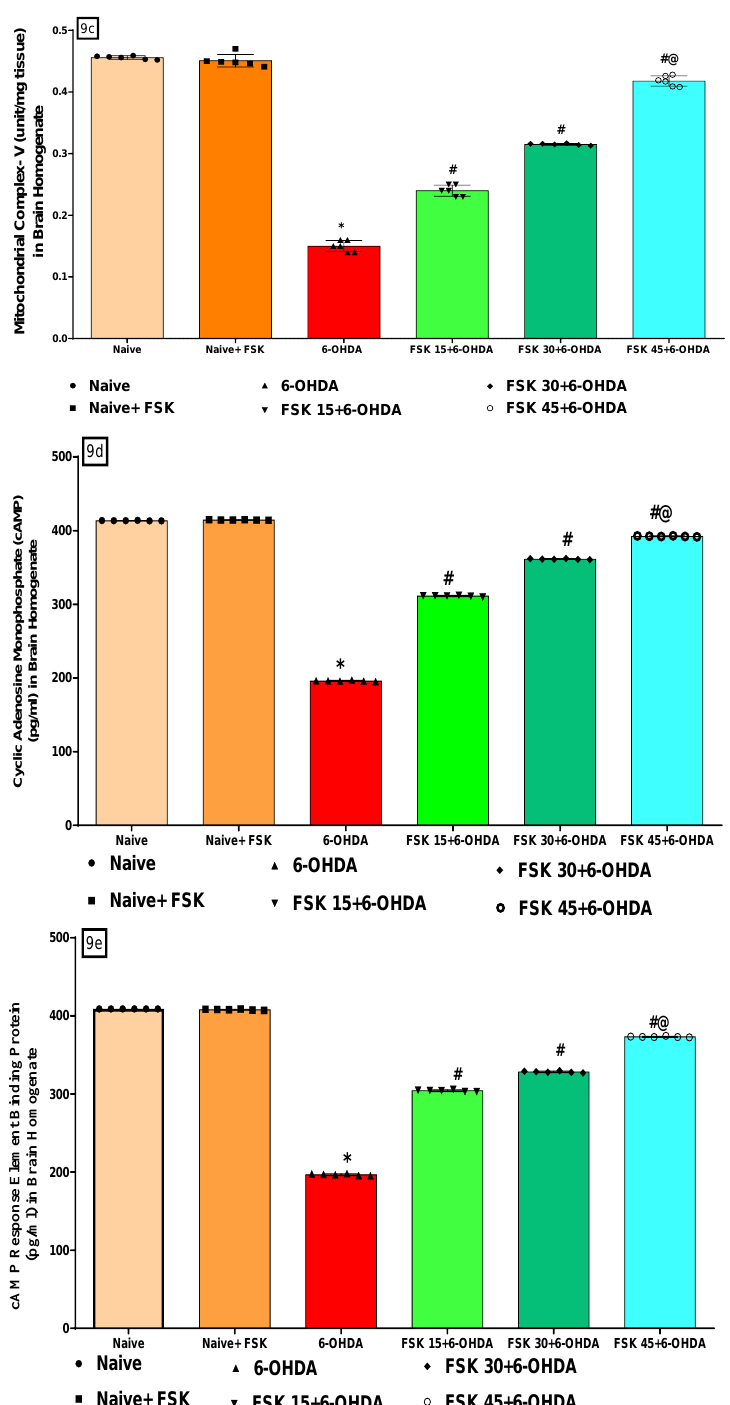
Figure 9. ( a – c ) FSK restored ETC-complexes (I, II, V) enzyme levels in the experimental model of PD. Data provided as mean ± SD (n = 6) followed by ANOVA (one-way) with post-hoc Tukey’s test. * 6-OHDA ( p < 0.01) compared with naive and naive + FSK ; # FSK15, FSK30, FSK45 (p < 0.01) compared with 6-OHDA ; #@ FSK45 (p < 0.01) compared with FSK30, FSK15 . ( d , e ) FSK improved cAMP and CREB protein levels in the experimental model of PD. Data provided as mean ± SD (n = 6) followed by ANOVA (one-way) with post-hoc Tukey’s test. * 6-OHDA ( p < 0.01) compared with naive and naive + FSK # FSK15, FSK30, FSK45 (p < 0.01) compared with 6-OHDA ; #@ FSK45 (p < 0.01) compared with FSK30, FSK15 . FSK Improved cAMP and CREB Protein Levels in the Experimental Model of PD At the end of the protocol schedule, molecular markers (cAMP and CREB) were measured in the rats’ brain homogenate. The naive and naive + FSK (45 mg/kg p.o.) groups showed no statistically significant differences. In contrast to the naive and naive + FSK groups, the amount of cAMP and CREB proteins gradually decreased following the continuous injection of 6-OHDA (8 μg/2 μL/unilateral). Furthermore, the chronic ad- ministration of FSK at doses of 15, 30 and 45 mg/kg compared to the 6-OHDA-treated group showed a significant increase in cAMP [F 5,25 = 1.660; ANOVA (one-way); p < 0.01 (Figure 9d) and CREB [F 5,25 = 1.546; ANOVA (one-way); p < 0.01] (Figure 9e) levels in a dose-dependent manner. In rats with 6-OHDA-induced PD, a high dose of FSK (45 mg/kg) demonstrates a significant improvement in restoring the levels of cAMP and CREB. 2.2.3. FSK Modulated Inflammatory Cytokines in the Experimental Model of PD At the end of the treatment, inflammatory cytokines (TNF- α, IL - 1β, IL -6, IL-10) were measured in the rats’ brain homogenate. Naive and Naive + FSK (45 mg/kg p.o.) showed no statistically significant differences. Compared to the naive and naive + FSK groups, there was a steady increase in TNF- α, IL - 1β and IL -6 levels and a decrease in IL-10 levels after the chronic administration of 6-OHDA (8 μg/2 μL/unilateral). The chronic treatment of FSK at 15, 30 and 45 mg/kg decreased TNF- α [F 5,25 = 0.1271; ANOVA (one-way); p <